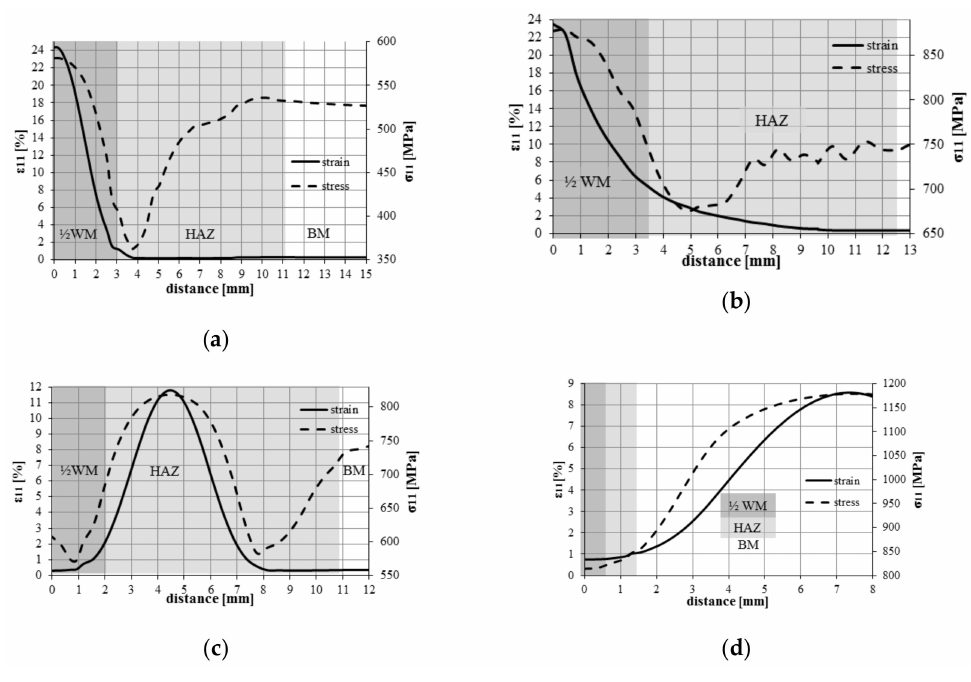
Figure 15. Stress and strain distribution along the center line inside the welded joints: ( a ) Q 1; ( b ) Q 2; ( c ) Q 3; ( d ) Q 5.